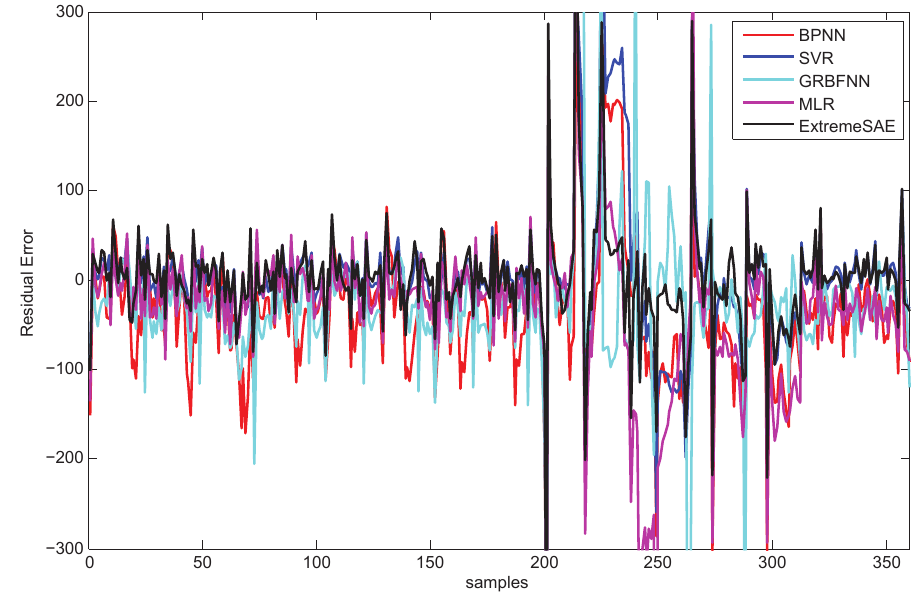
Figure 13. Residual errors of the five models in the 60 min prediction experiment.